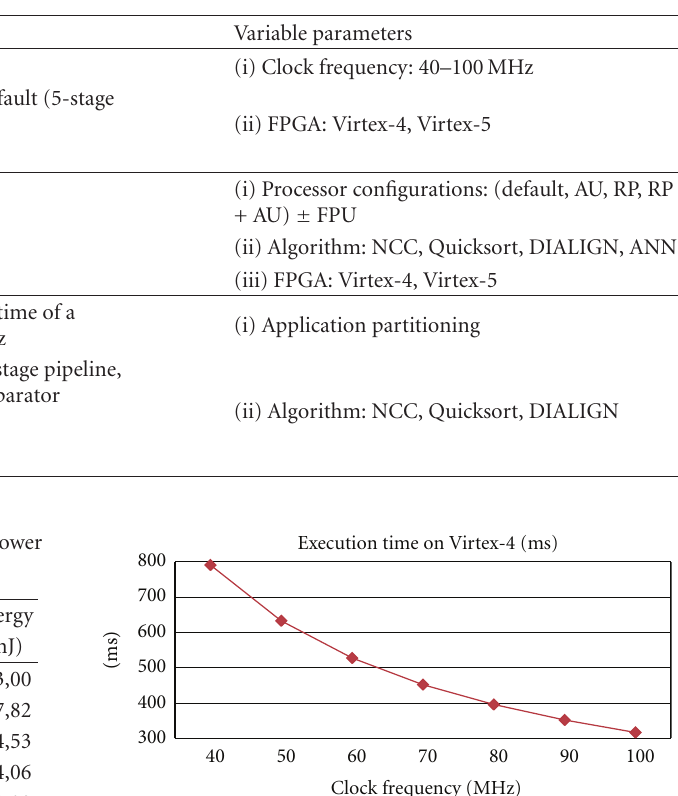
Table 2: Fixed parameters for the exploration of the impact of the clock frequency, the processor configuration, and the task distribution on the performance, power dissipation, and energy consumption.